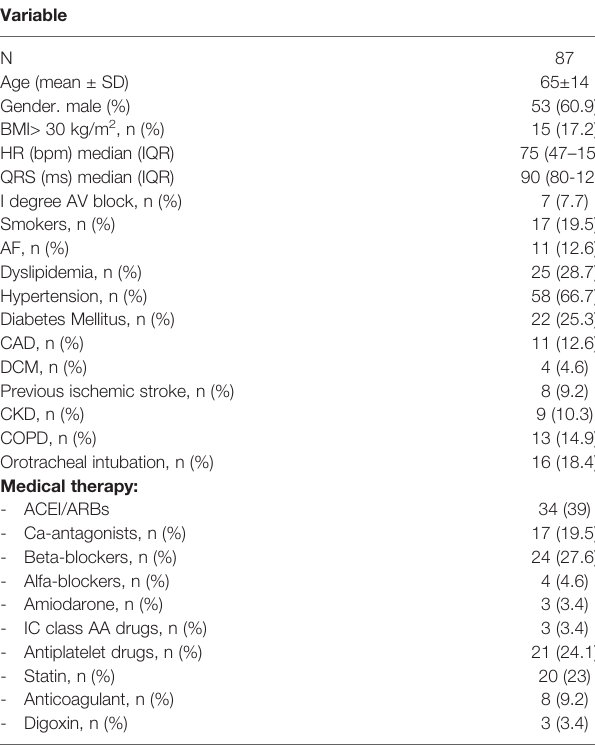
BMI, body mass index; HR, heart rate; AV, atrio-ventricular; AF, atrial fi brillation; CAD, coronary artery disease; CKD, chronic kidney disease; COPD, chronic obstructive pulmonary disease; DCM, dilated cardiomyopathy; ACEI, angiotensin converting enzyme inhibitor; ARBs, angiotensin II receptor blockers; AA,